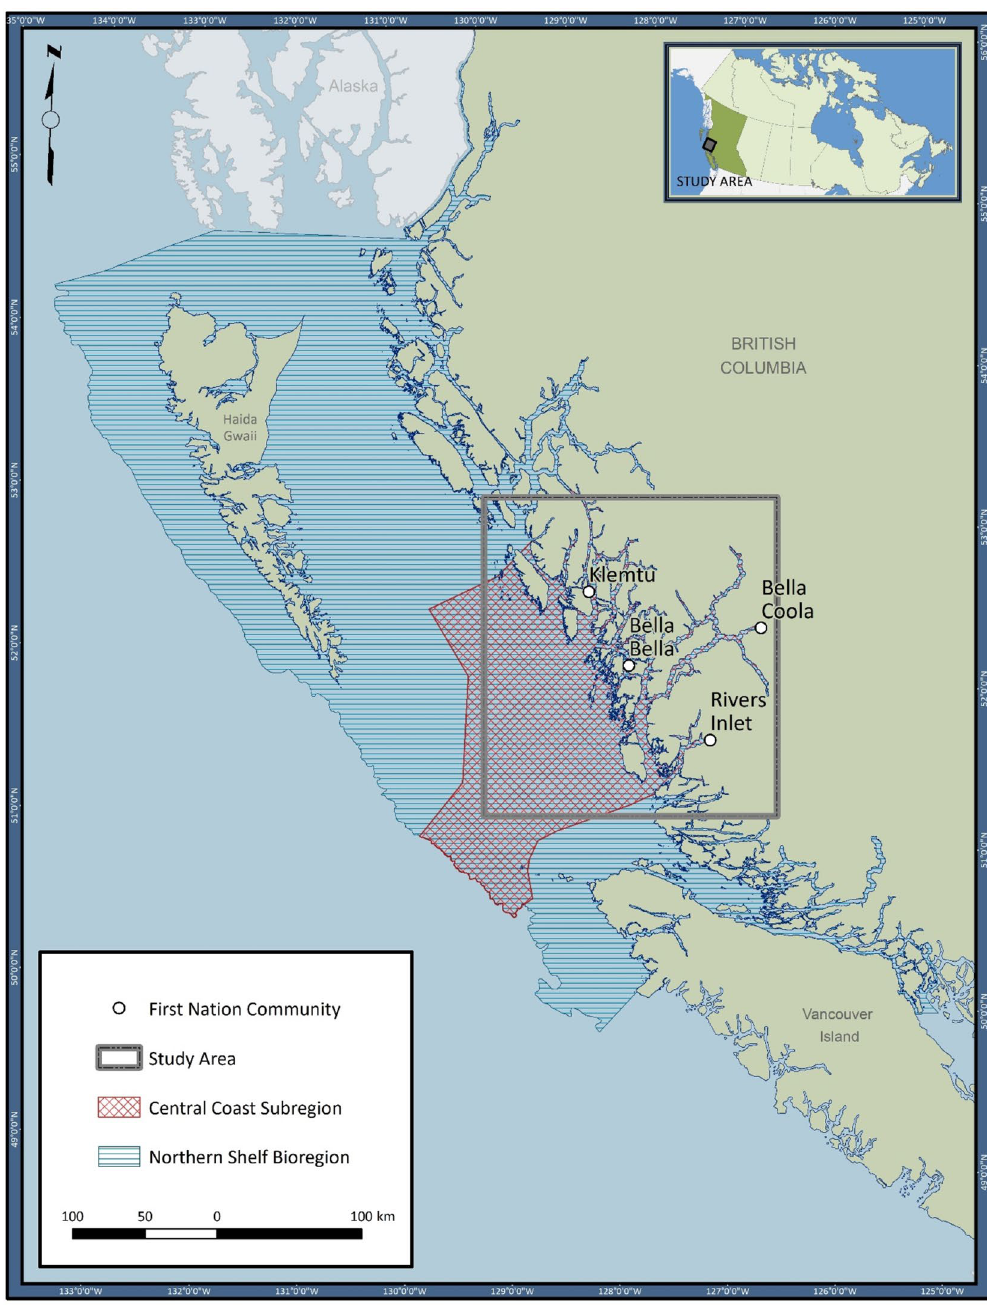
Figure 1. Map of the study area in the context of the Northern Shelf Bioregion, Pacific Canada. (Figure was created with ArcGIS Desktop, Version 10.8.1: https:// www. esri. com/ en- us/ arcgis/ produ cts/ arcgis- deskt op/ overv